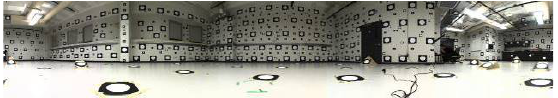
Figure 2. Indoor calibration room at the University of